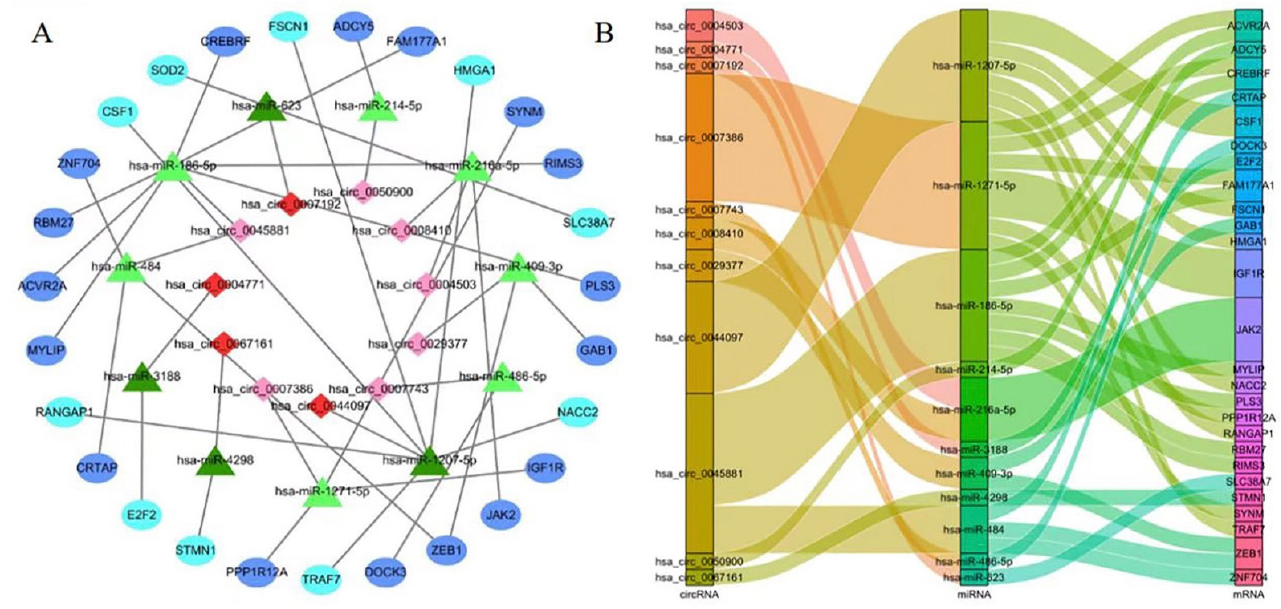
Figure 3. The circRNA-microRNA-mRNA network. ( A ) The ceRNA network. The oval represents mRNA, the triangle represents miRNA, and the diamond represents cicRNA. Among the corresponding shape genes, the light color represents downregulated in TAD, and the dark color represents upregulated in TAD. ( B ) Sankey diagram for the ceRNA network in TAD. Each rectangle represents a gene, and the connection degree of each gene is visualized based on the size of the rectangle.